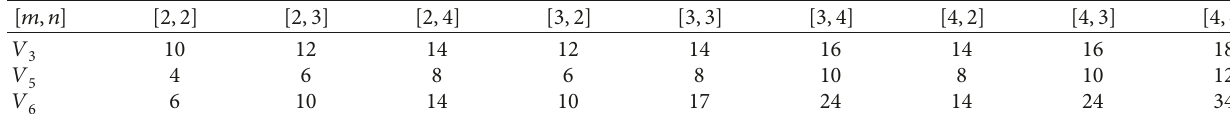
Table 1: Vertex partition of Sb